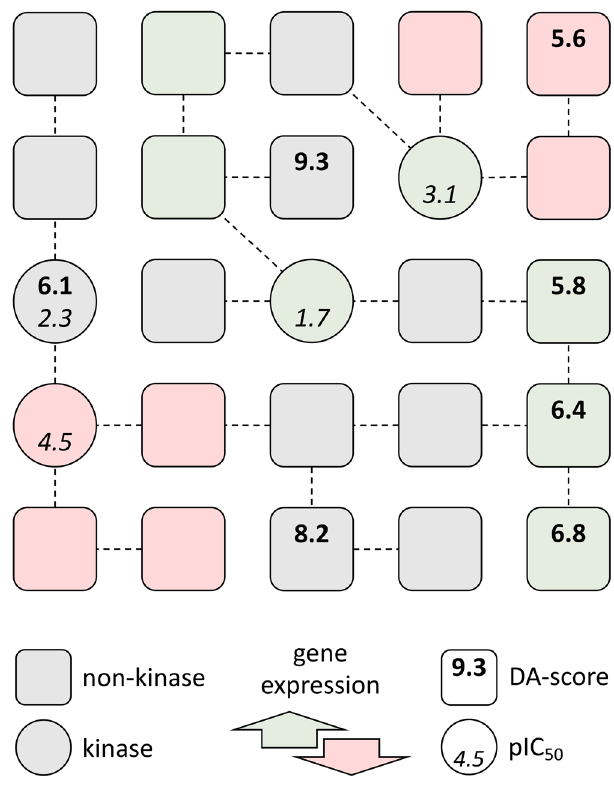
Fig. 1 Schematic of the graph representation of multiple heterogeneous data. Circles are kinases, whereas rounded squares represent non-kinase proteins. Nodes are connected through con fi dent interactions forming a network. Each node is colored according to the differential gene expression: green — up-regulated, red — down-regulated, and gray — normally regulated. Both types of nodes can have gene-disease association scores (numbers in bold), whereas kinases can also have pIC 50 values according to the kinase pro fi ling data (numbers in